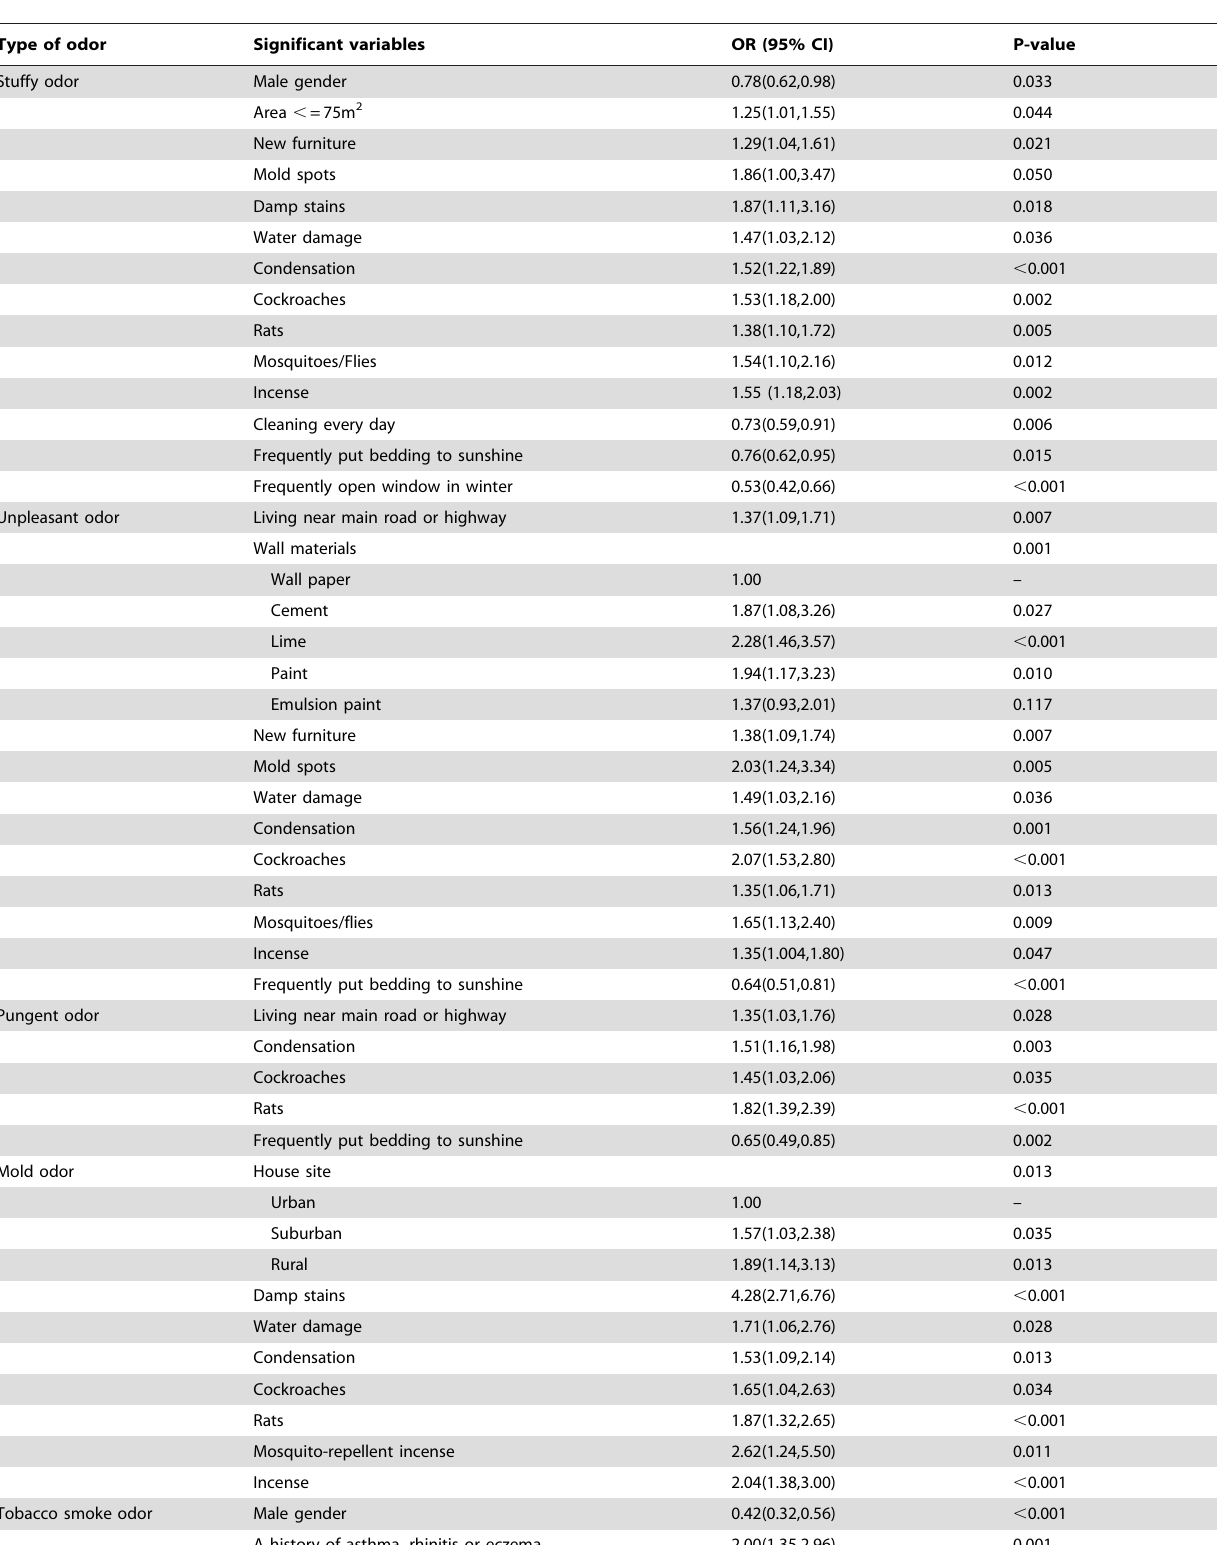
Table 8. Significant variables associated with odor perception (weekly or sometimes), obtained by forward stepwise logistic regression